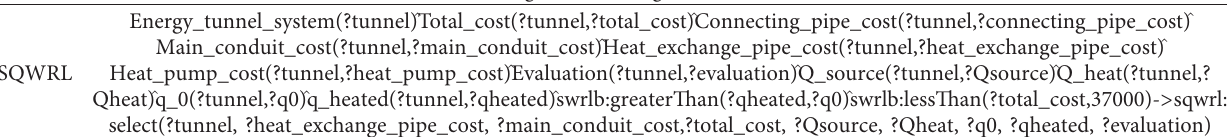
Figure 11: Execution and results of Table 9. Table 10: SQWRL rule for selecting feasible design schemes with cost below 37000